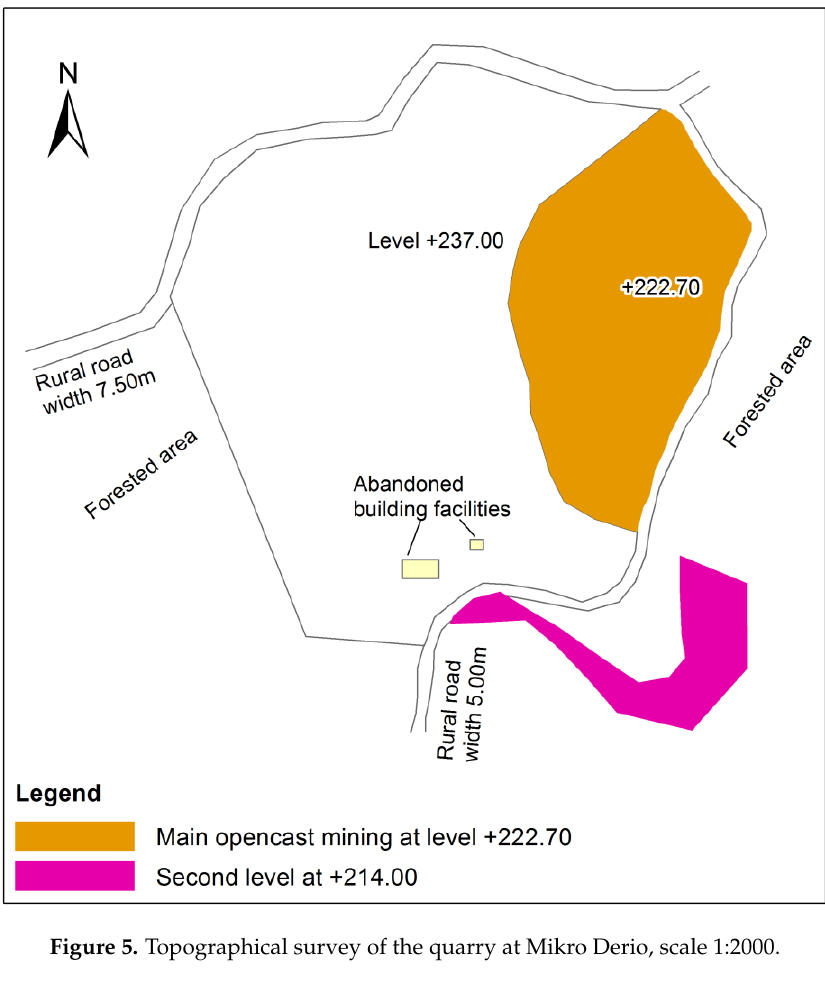
Figure 5. Topographical survey of the quarry at Mikro Derio, scale 1:2000.